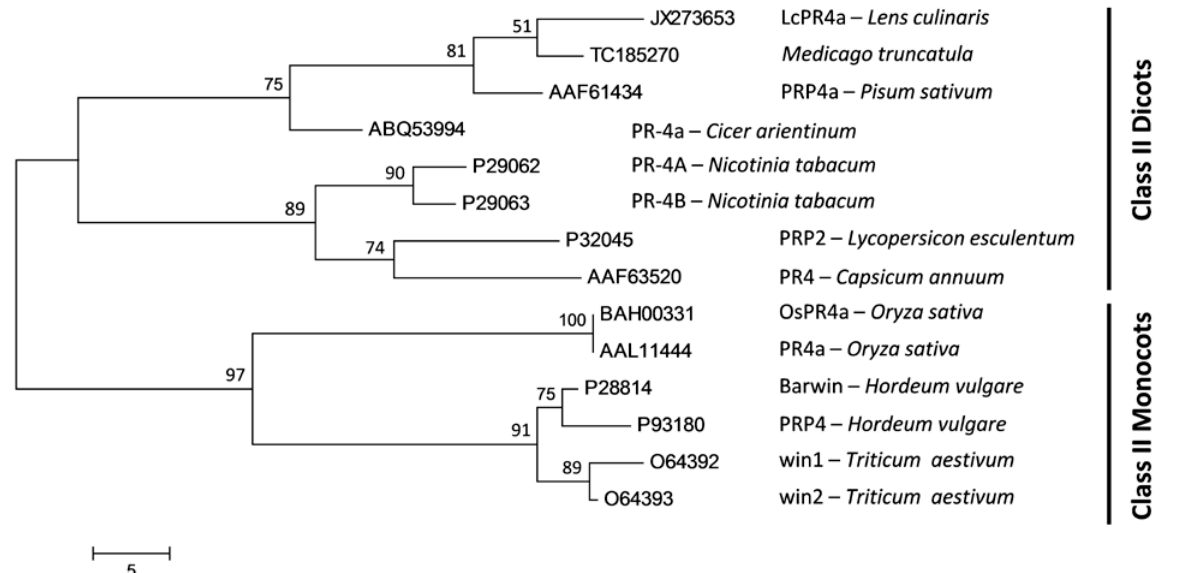
Figure 2. Phylogenetic relationship of class II PR4 proteins, showing close affinity of LcPR4a to PR4 proteins of other legumes. GenBank accession numbers for proteins are indicated, except for Medicago truncatula putative PR4 protein (TC185270) which was sourced from DFCI Medicago truncatula Gene Index (MtGI). The bootstrap consensus tree was con - structed using Maximum Parsimony method and SPR algorithm. The percentage of replicate trees in which the associated taxa clustered together in the bootstrap test (1000 replicates) is shown above the branches. Branches with less than 50% bootstrap replicates were collapsed.